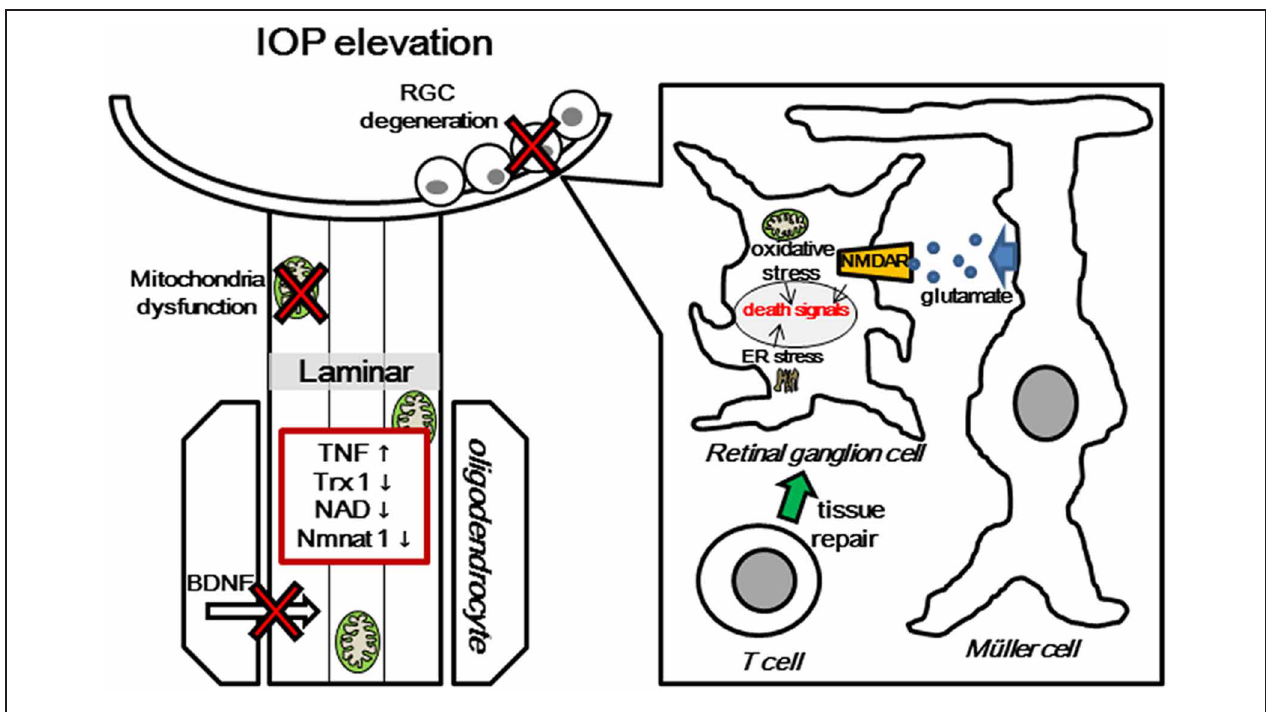
FIGURE 2 | Multiple pathogenicand biological mechanisms for glaucomatous neurodegeneration. Increased IOP induces several molecularchanges, suchasglialactivationandreleaseofTNF,mitochondrial dysfunction, degradation of Trx1, NAD, and nmnat1, and obstruction ofBDNFtransportatlaminaarea.Molecularchangesintheaxoncausedeath